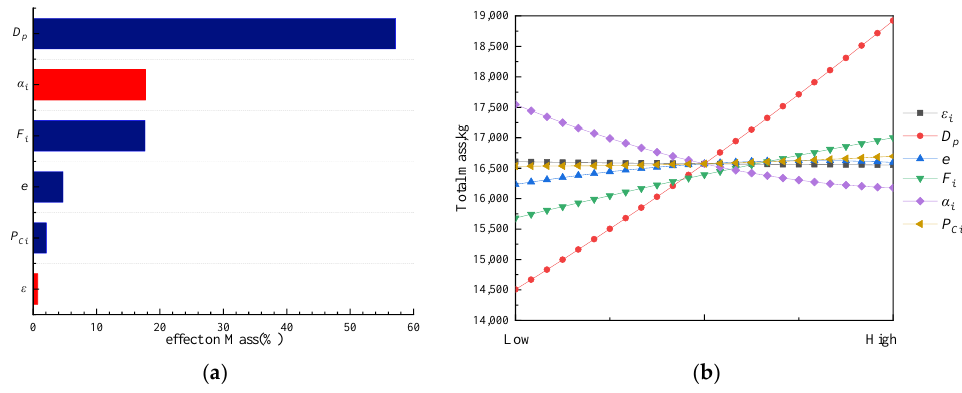
Figure 16. Parametric analysis of design variables to mass. ( a ) Pareto diagram; ( b ) main effect plot.